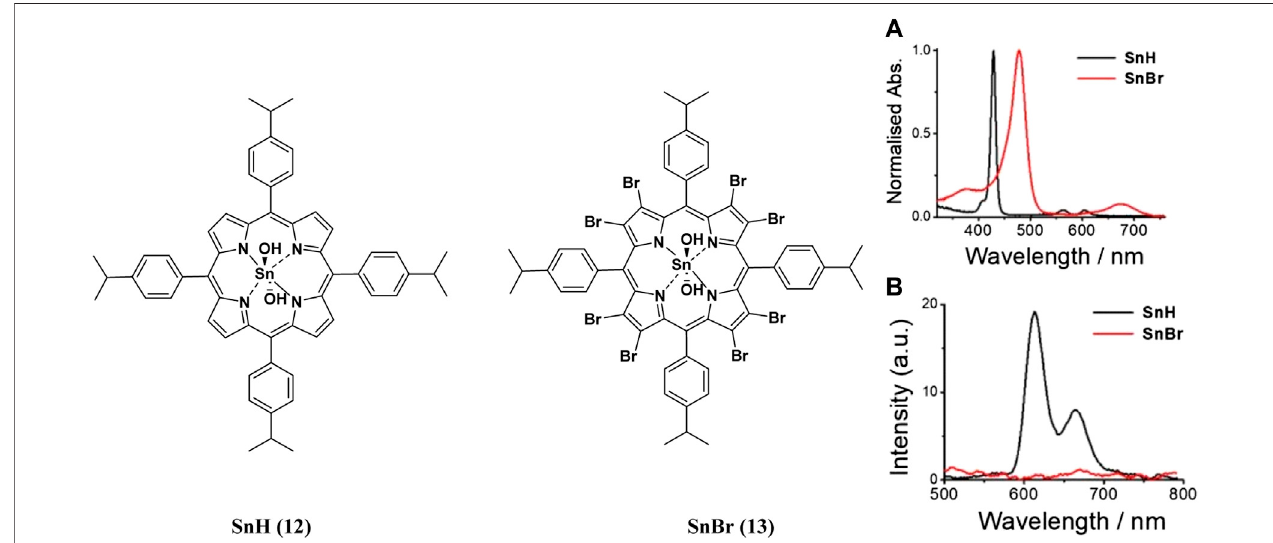
FIGURE4 | (A) UV-Vis absorption (B) and emission spectra ofporphyrins 12 and 13. These indicate the redshift in wavelengthof absorption and quenching of the fl uorescence upon bromination of the porphyrin. Reproduced with permission from porphyrin. Reproduced with permission from (Babu et al., 2020a).